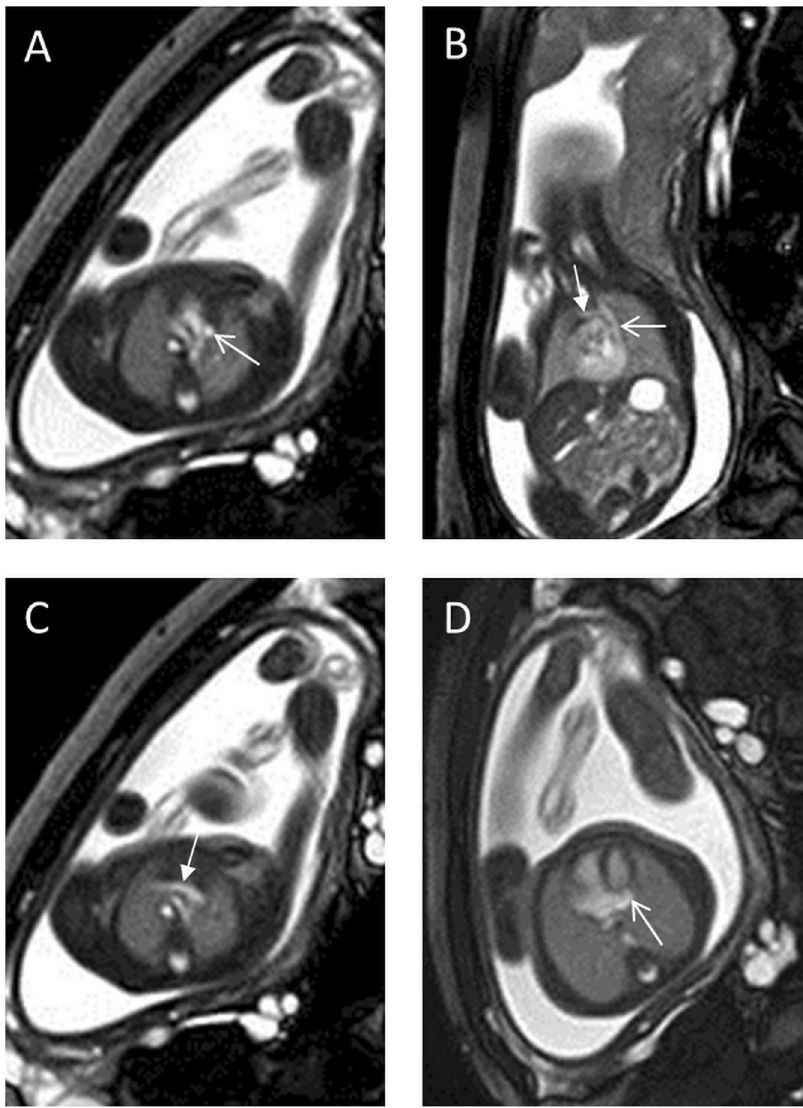
Figure 6. A 24-week fetus with absent right superior vena cava and persistent LSVC. Fetal CMR B-TFE transverse, oblique sagittal, and four-chamber views show the absence of the right superior vena cava, persistent LSVC (open arrows in A and B ), a bridging vein (arrows in B and C ), and an enlarged coronary sinus (open arrow in D